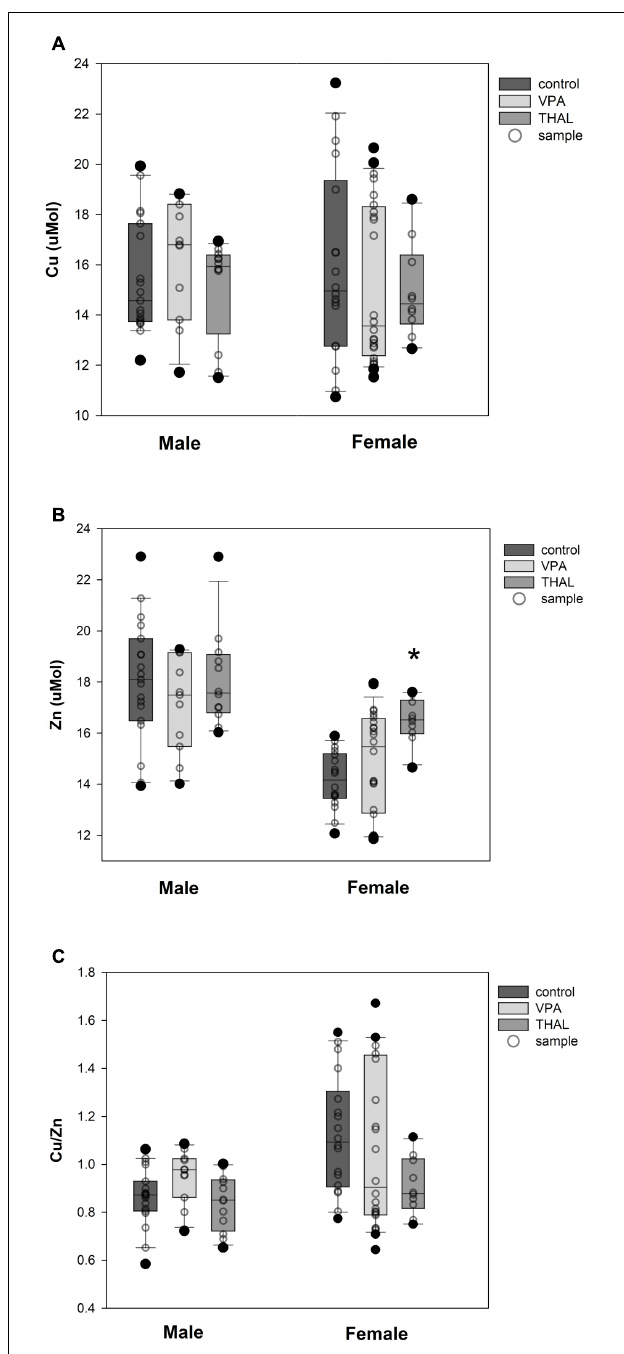
FIGURE 2 | Box and Whiskers plot of changes in Cu (A) , Zn (B) , and Cu/Zn (C) levels in rats’ serum measured using the ICP-MS method. The obtained results are expressed in µ M concentration (A,B) . Number of samples: n = 37 (18F + 19M) – control group, n = 35 (24F + 11M) – VPA-treated rats, and n = 22 (10F + 12M) – THAL-treated animals; F – female; M – male rats; (*) represents results statistically significant vs. control, p < 0.05, one-way ANOVA followed by Holm-Sidak corrections; box containing 50% of results that fell in the range between 25% (bottom line) and 75% (top line) – IQR (InterQuartile Range), (–) median value, whiskers – min and max values, ( • ) – outliers ( ± 1.5 × IQR), ( ◦ ) – individual